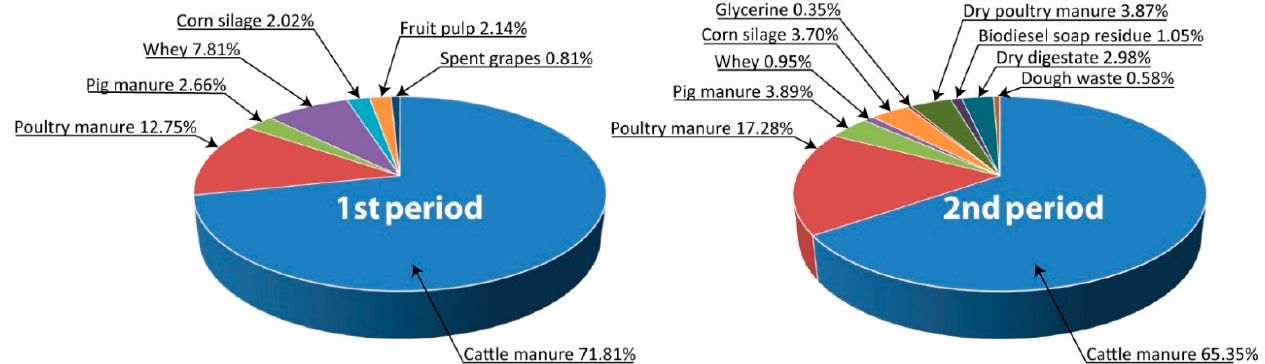
Figure 1. Mixing weight ratio of the different substrates utilized in the 1st and 2nd period of examination by the biogas plant for the creation of the feedstock.